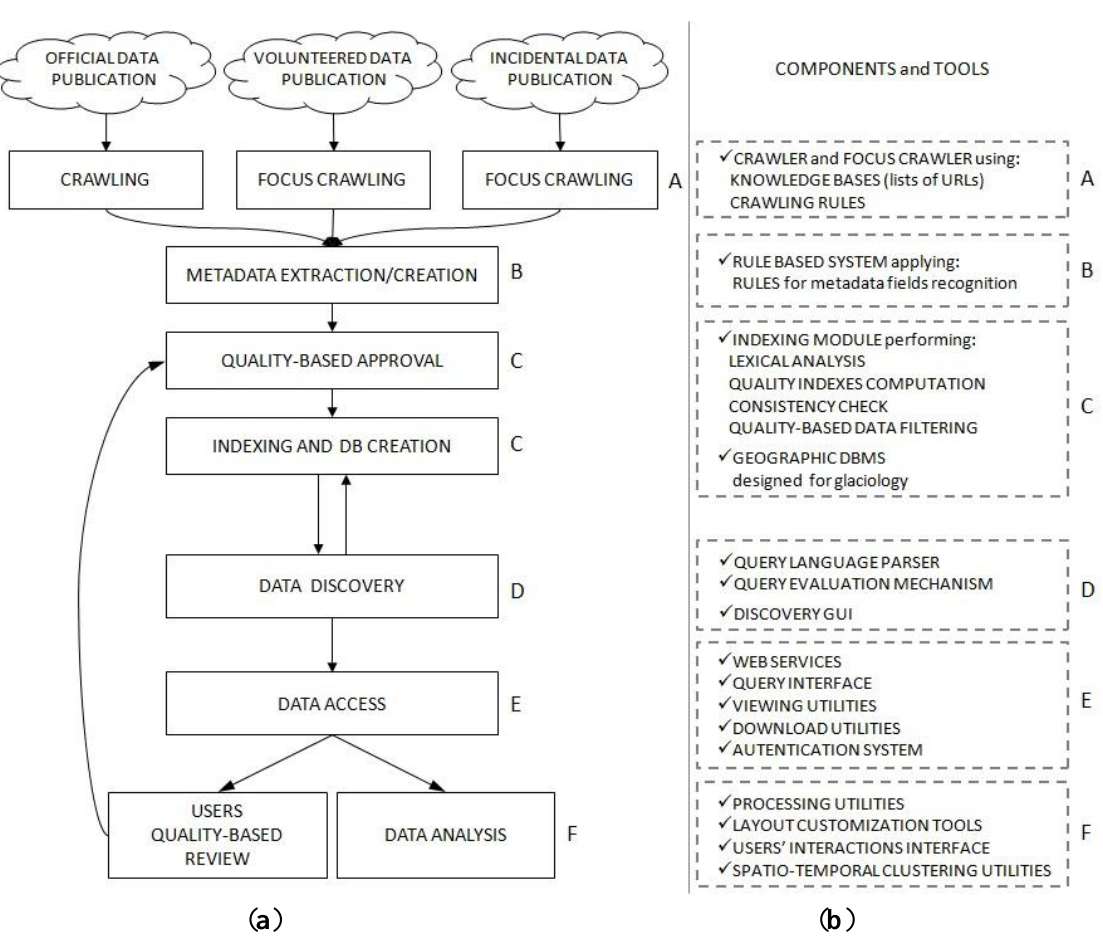
Figure 3. Representation of the proposed methodology: ( a ) functionalities and ( b )